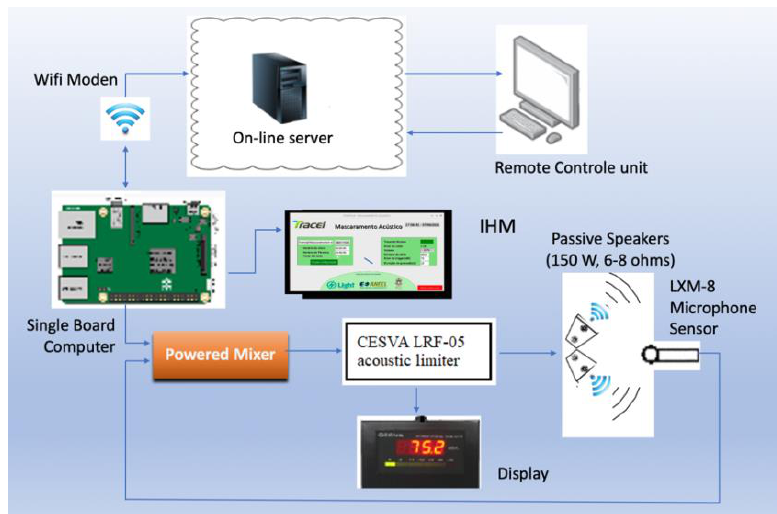
Figure 6. Block diagram of the masking system.